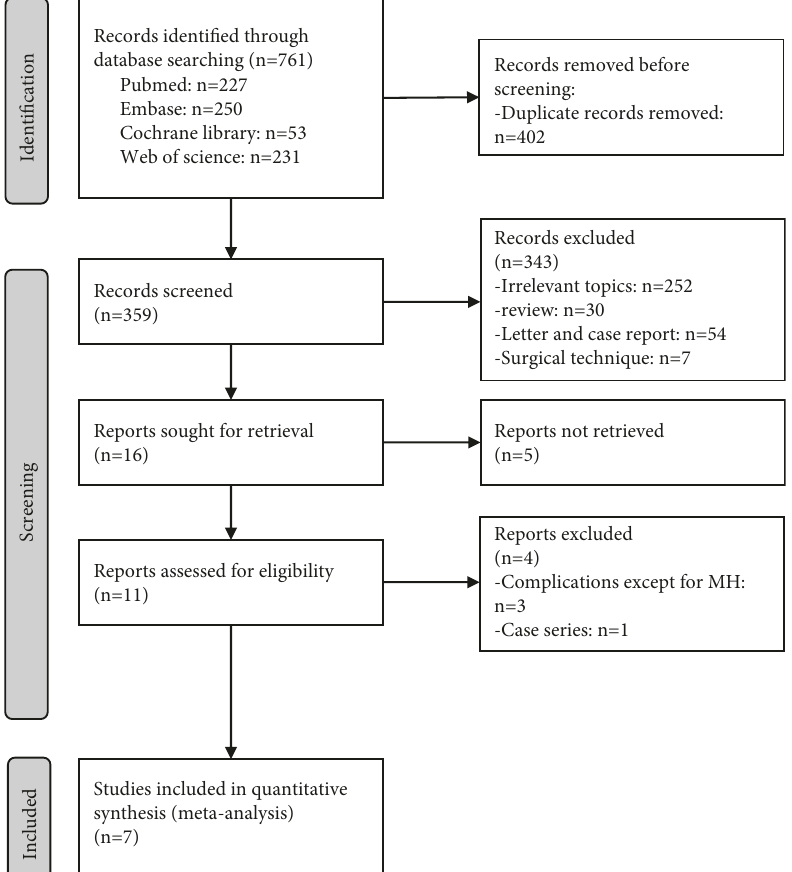
Figure 1: PRISMA flow diagram of the literature screening